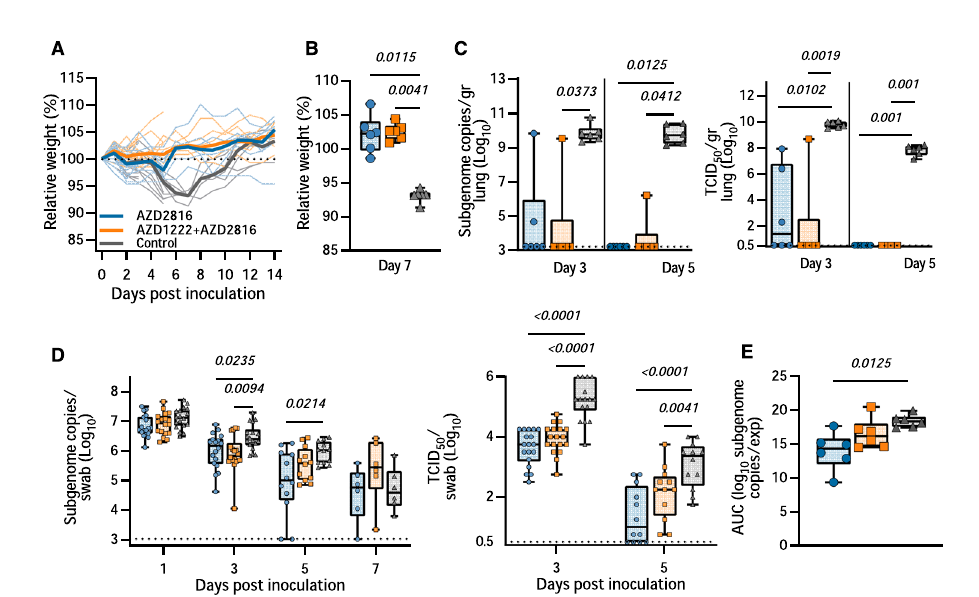
Fig. 4 | Vaccination of Syrian hamsters with AZD2816 or AZD1222 followed by AZD2816 reduces lower respiratory tract infection by the Delta VoC. Twenty- eight days post fi nal vaccination, hamsters were challenged with 10 4 TCID 50 of the Delta variant via the intranasal route. A Relative weight in comparison to day 0. Thick lines=median weight per group, thin lines=individual animals, dotted line=100% relative weight. Days 0 – 3 N =18, Days 4 – 5, N =12, Days 6 – 14 N =6.. B Boxplot (minimum to maximum) of relative weight at day 7. Statistical sig- ni fi cance was determined via a Kruskall-Wallis test followed by Dunn ’ s multiple comparisons test. C Boxplot (minimum to maximum) of sgRNA (left panel) and infectious virus isolation (right panel) in lung tissue harvested on days 3 and 5 ( N =6).Statisticalsigni fi cancewasdeterminedviaaKruskall-Wallistestfollowedby Dunn ’ s multiple comparisons test. Dotted line=limit of detection. D Boxplot (minimum to maximum) of sgRNA (left panel) and infectious virus (right panel) in